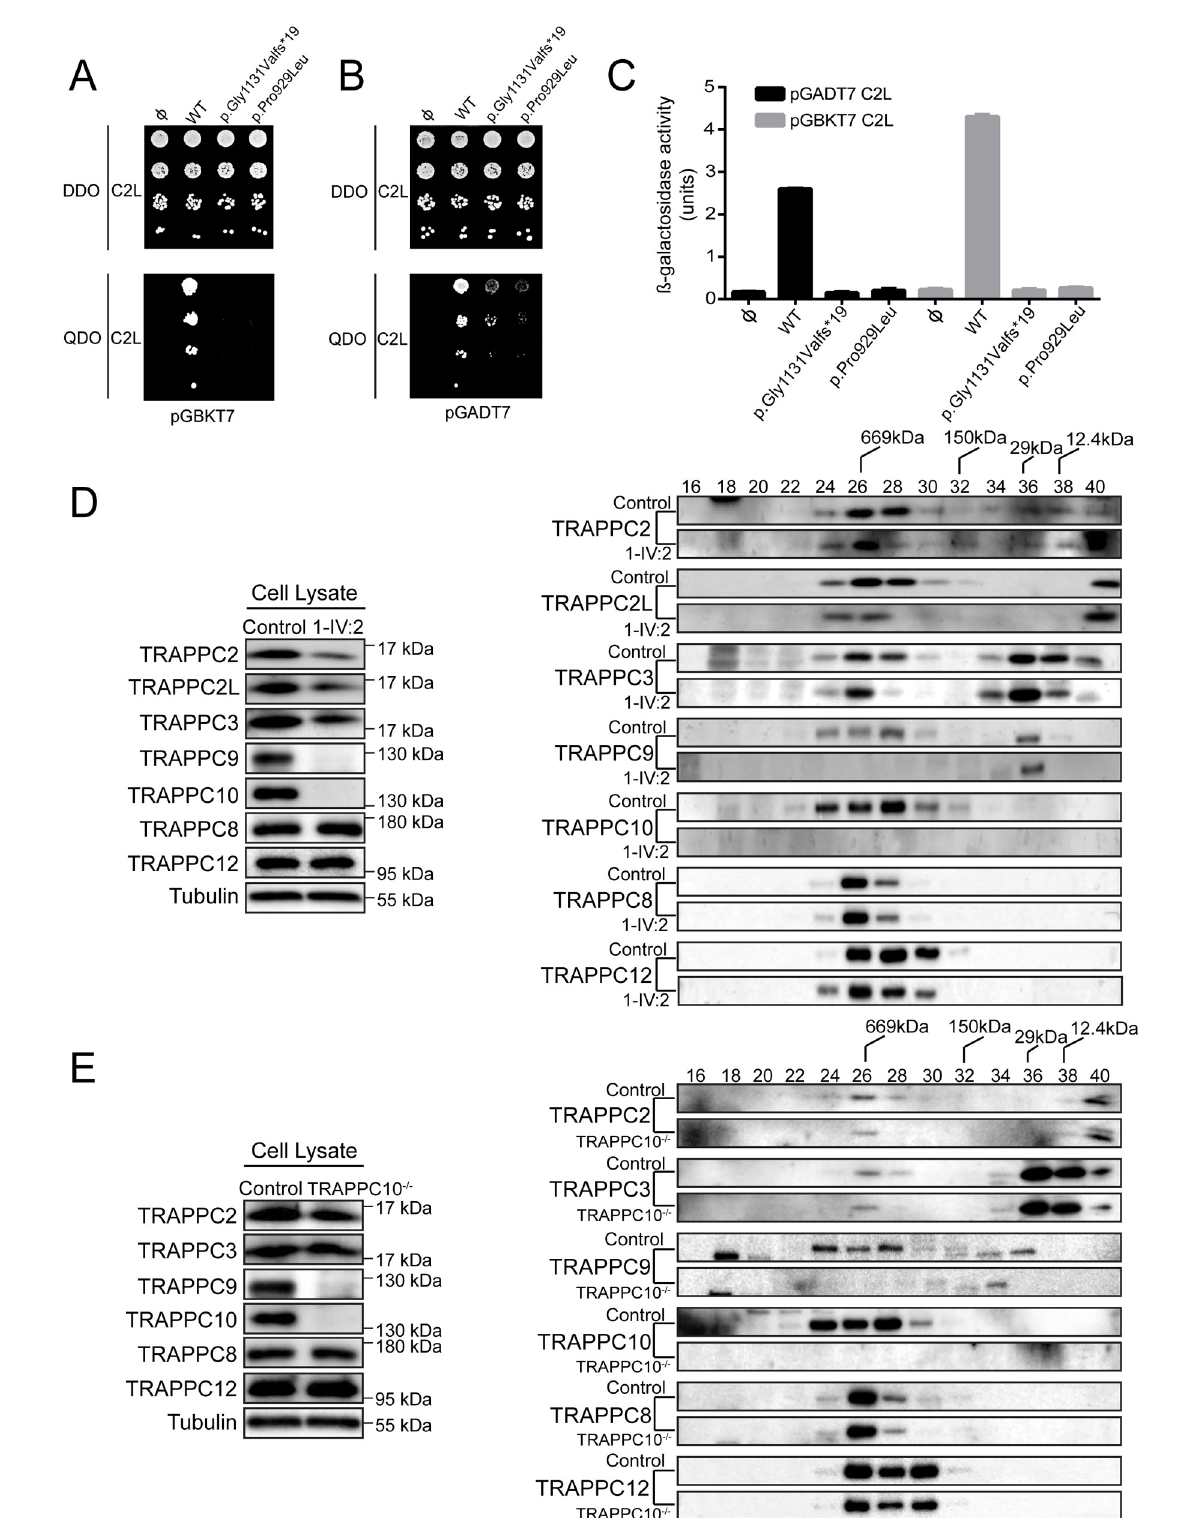
Fig 2. TRAPP II complex integrity is affected by TRAPPC10 variants and in TRAPPC10 -/- cells. Yeast cells transformed with pGBKT7 or pGBKT7 expressing either wild type TRAPPC10, the p.Gly1131Valfs � 19 variant or the p.Pro929Leu variant ( A ), or pGADT7 or